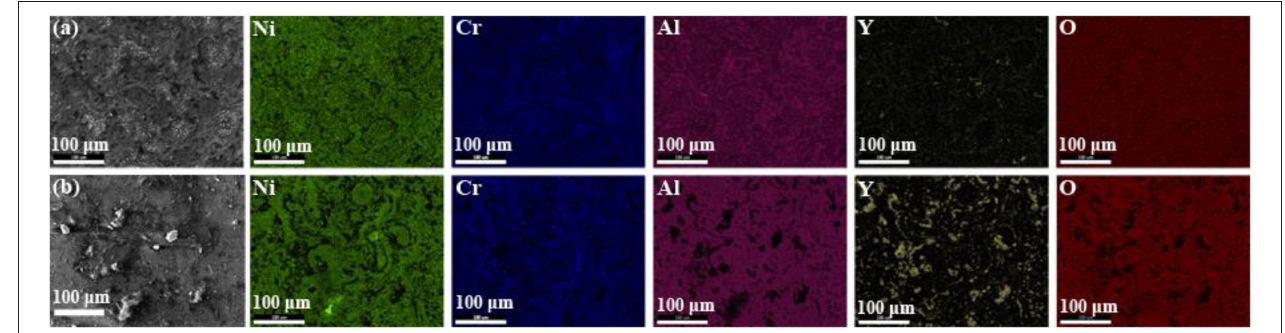
FIGURE 14 | SEM morphologies of NiCrAlY coating surfaces after 1,100 ◦ C heat treatment at (a) 900 ◦ C and (b) 1,000 ◦ C oxidized for 100h and corresponding element